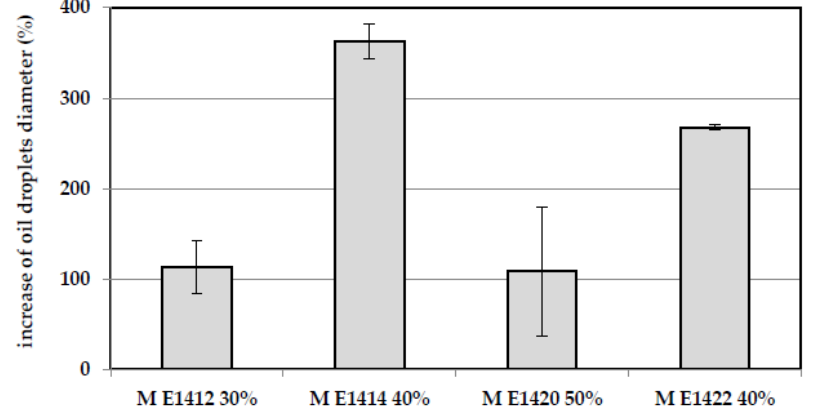
Figure 2. The increase of oil droplets diameter in DE 6 maltodextrins-based emulsions after a week storage